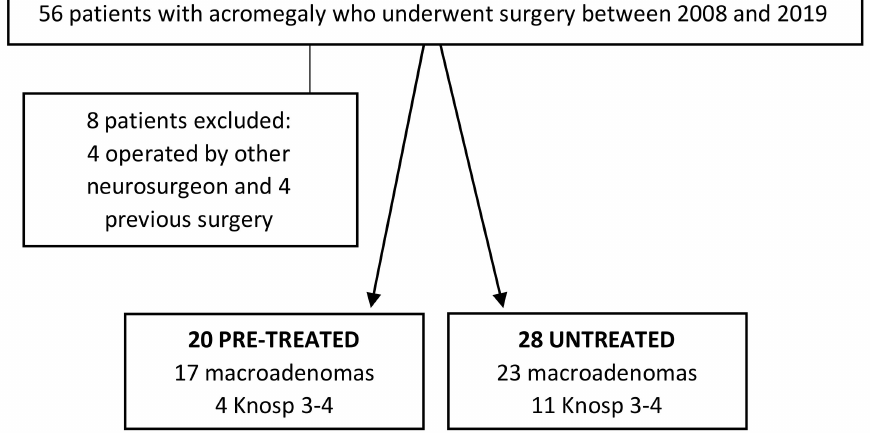
Figure 1. Flowchart of the study